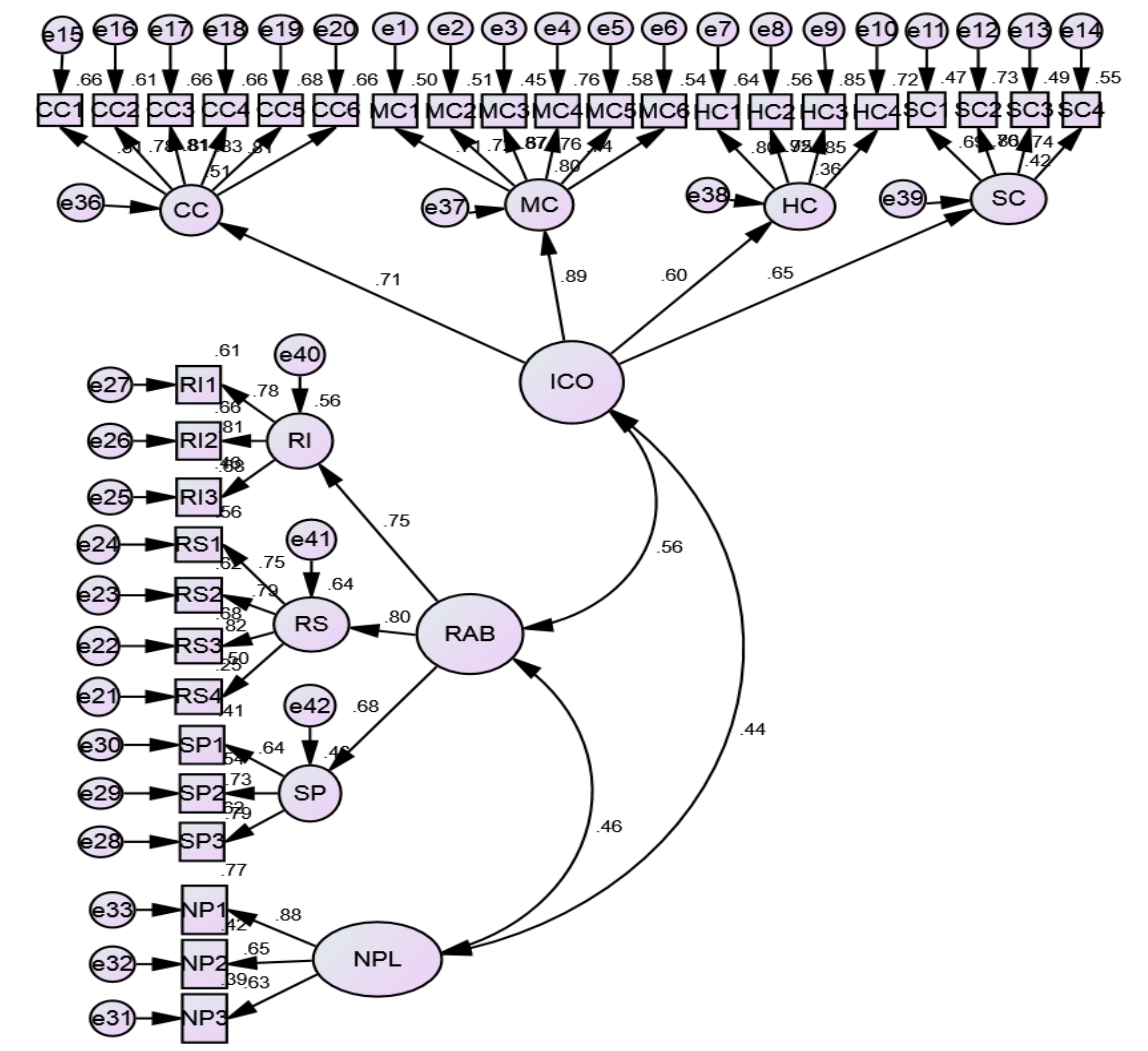
Figure 1. Measurement model of investors’ cognition.